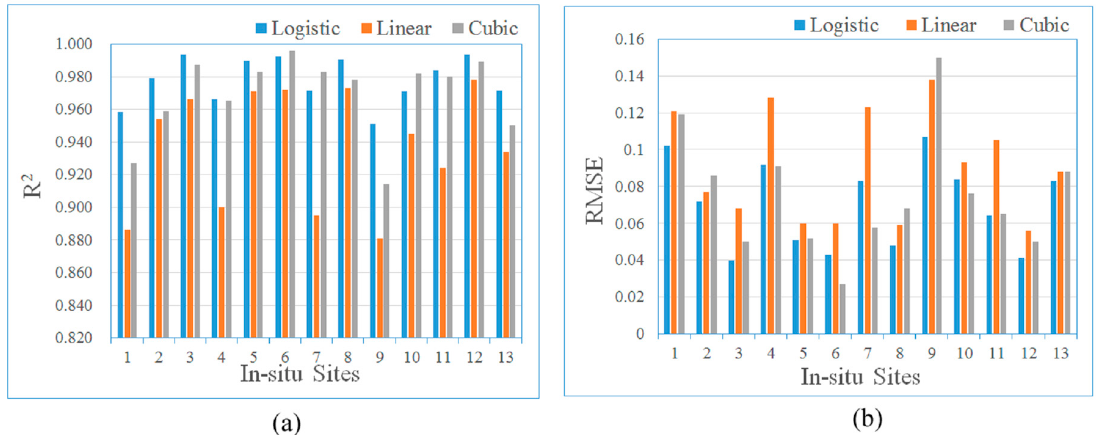
Figure 9. Comparison of the fitting results from logistic, linear and cubic interpolations in: ( a ) correlation coefficient ( R 2 ); and ( b ) RMSE.